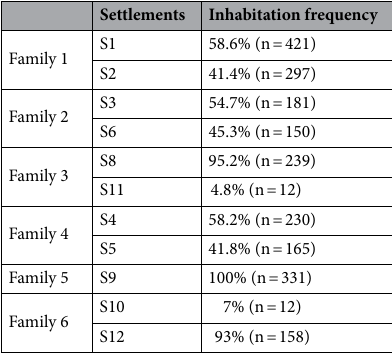
Table 1. Inhabitation frequencies (days of inhabitation (n)/total days of monitoring) of each porcupine family in each settlement during the whole investigation